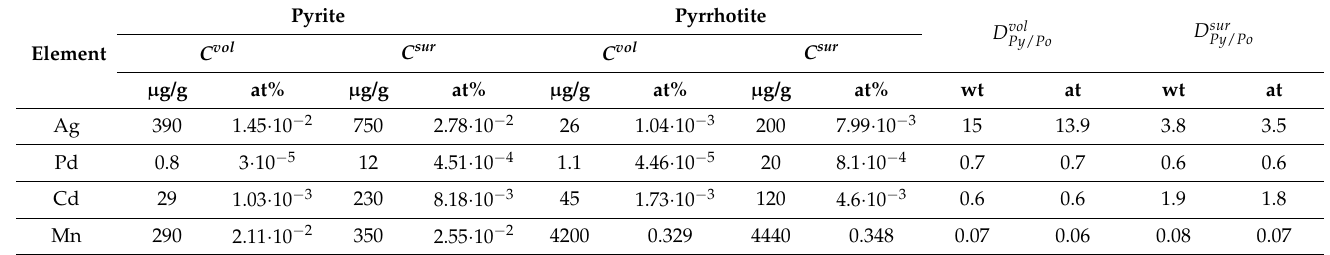
Table 3. Element contents in the volume of crystal and in near-surface regions (within ~20 µ m) of pyrite and pyrrhotite crystals from LA-ICP-MS data, and volume and surficial distribution coefficients.